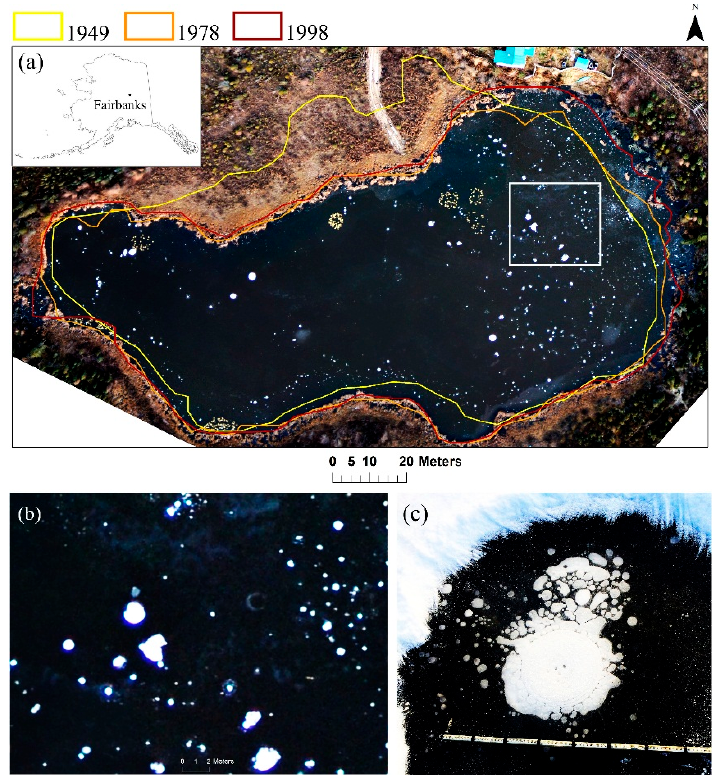
Figure 1. ( a ) Location of the study area (64.91° N, 147.84° W; 195 m a.s.l.) in Alaska and true color composite of an aerial image of Goldstream Lake, Fairbanks, AK, USA photographed from a fixed-wing airplane using a Nikon D300 photo camera on 13 October 2012. The yellow (1949 shoreline), orange (1978 shoreline) and red (1998 shoreline) polygons overlaid on the 2012 aerial image show the changing shoreline of the lake since 1949. ( b ) A closer view of lake ice (outlined as white box in the lake image a) shows the appearance of ebullition bubble patches as bright white spots on the aerial image. ( c ) is an example of methane ebullitions bubbles trapped in lake ice as seen on ground (measurement stick with 10 cm intervals for scale).